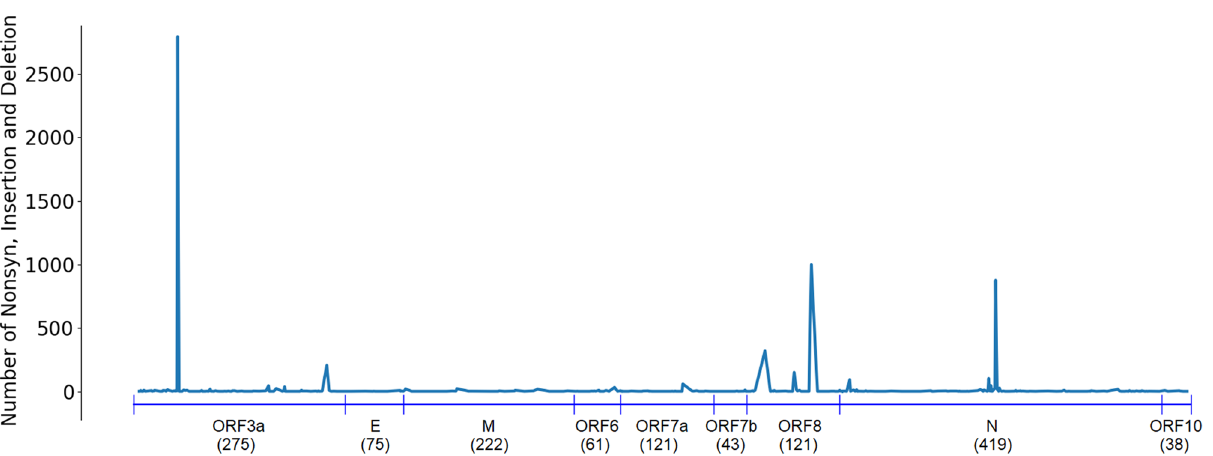
Figure 4. The number of insertion, deletion and nonsynonymous mutations at different locations in the proteins ORF3a, E, M, ORF6, ORF7a, ORF7b, ORF8, N and ORF10. The number below protein names are the length of that protein. Protein ORF3a: two spikes at Q57H (2795) and G251V (206); protein ORF8: two spikes at S24L (320) and L84S (1000); protein N: R203K (876) and G204R (433); Other proteins E, M, ORF6, ORF7a, ORF7b and ORF10 are almost entirely